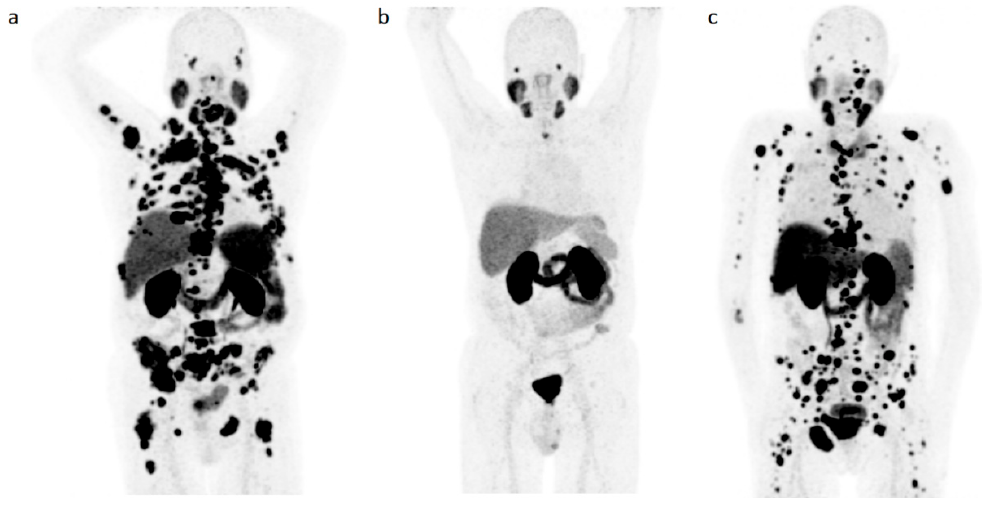
Figure 5. Example of [ 68 Ga]Ga-PSMA-11 PET/CT maximum intensity projection (MIP) of three patients with prostate cancer and different fractional total lesion [ 68 Ga]Ga-PSMA-11 uptake volume (TL-PSMA) with almost similar ( a , b ) and different ( a – c ) fractional [ 68 Ga]Ga-PSMA-11 uptake volume in the parotid glands (HT-PSMA parotid glands). ( a ) PSA: 63 ng/mL, administered 68 Ga-PSMA-11: 1.59 Mbq/kg, TL-PSMA: 9305.29 SUV*cm 3 , HT-PSMA parotid glands: 327.69 SUV*cm 3 ; ( b ) PSA: 4.60 ng/mL, administered 68 Ga-PSMA-11: 1.54 Mbq/kg, TL-PSMA: 26.00 SUV*cm 3 , HT-PSMA parotid glands: 363.36 SUV*cm 3 ; ( c ) PSA: 340 ng/mL, administered 68 Ga-PSMA-11: 1.61 Mbq/kg, TL-PSMA: 5767.73 SUV*cm 3 , HT-PSMA parotid glands: 133.23 SUV*cm 3